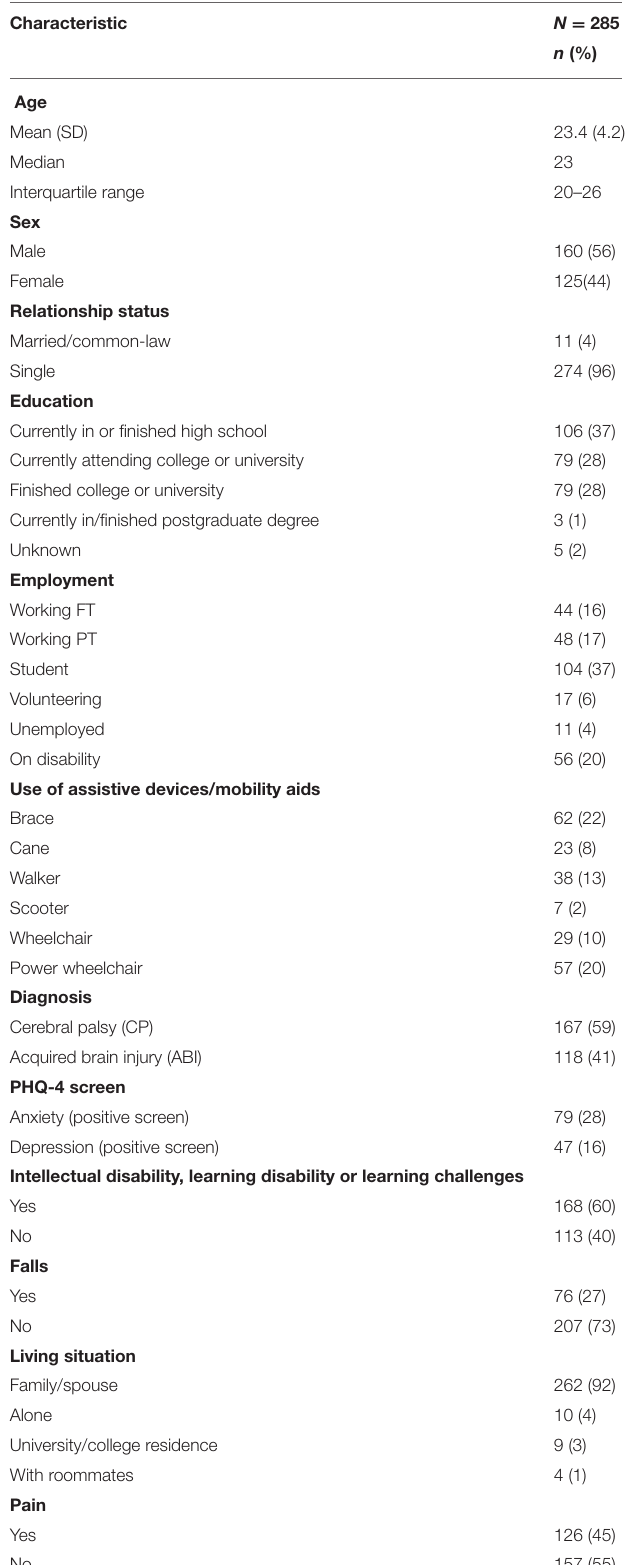
TABLE 1 | Demographic and clinical characteristics of patients of the LIFEspan